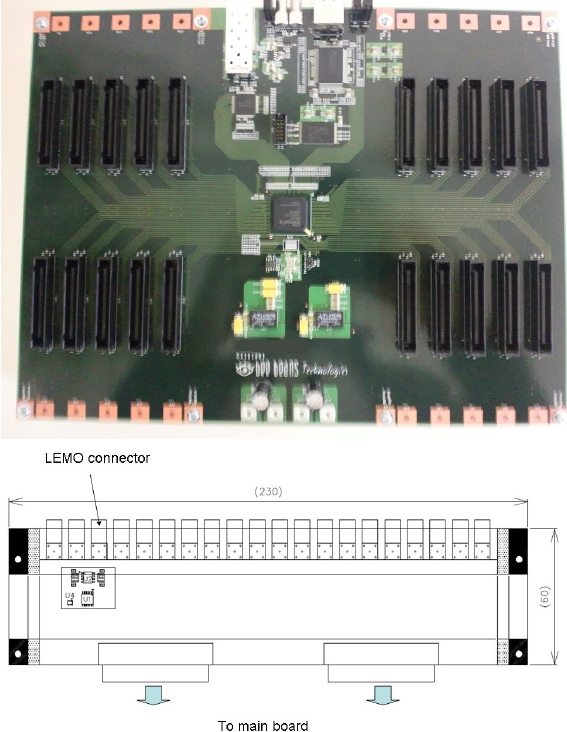
Fig. 2. 3 Fig. 2. Photograph of the main board of MURG12 (upper) and 4 the schematic side view of the daughter board (lower). U1 is for low voltage differential signaling. U2 is the low capacitance tran- sient voltage suppression (TVS) array. U4 is the low capacitance electrostatic-discharge- (ESD) protection diode